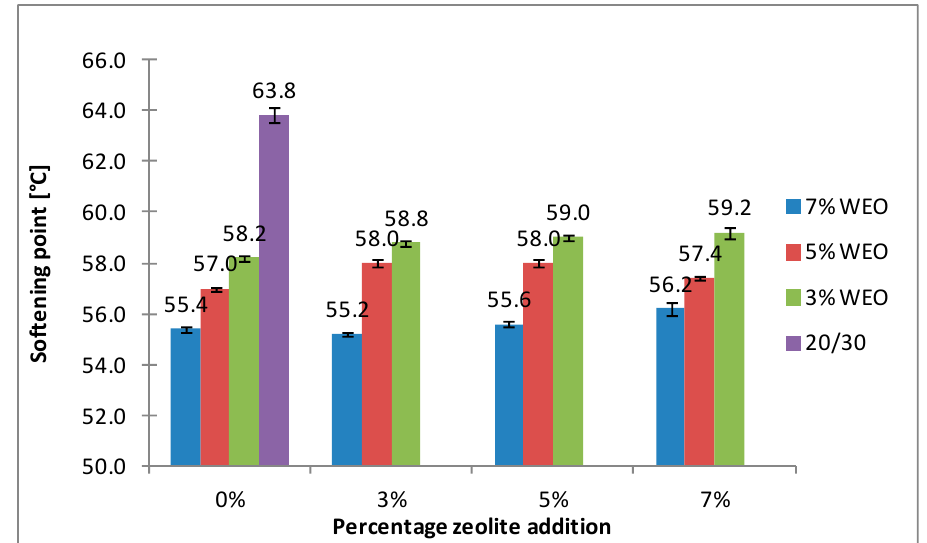
Figure 8. The results of softening point tests for the 20/30 asphalt with the addition of WEO and Na-P1 zeolite.